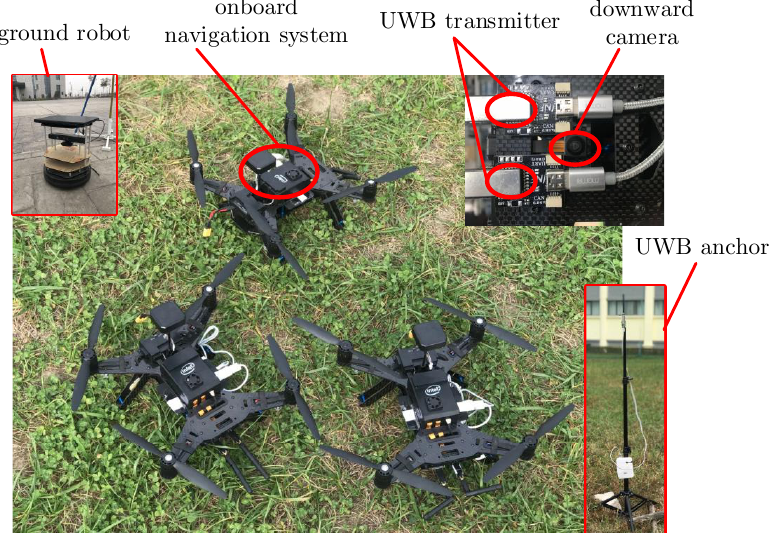
Figure 9. Intel Aero RTF quadrotors (equipped with an onboard navigation system, ultra-wide bandwidth (UWB) transmitters, and downward cameras) and the TurtleBot ground